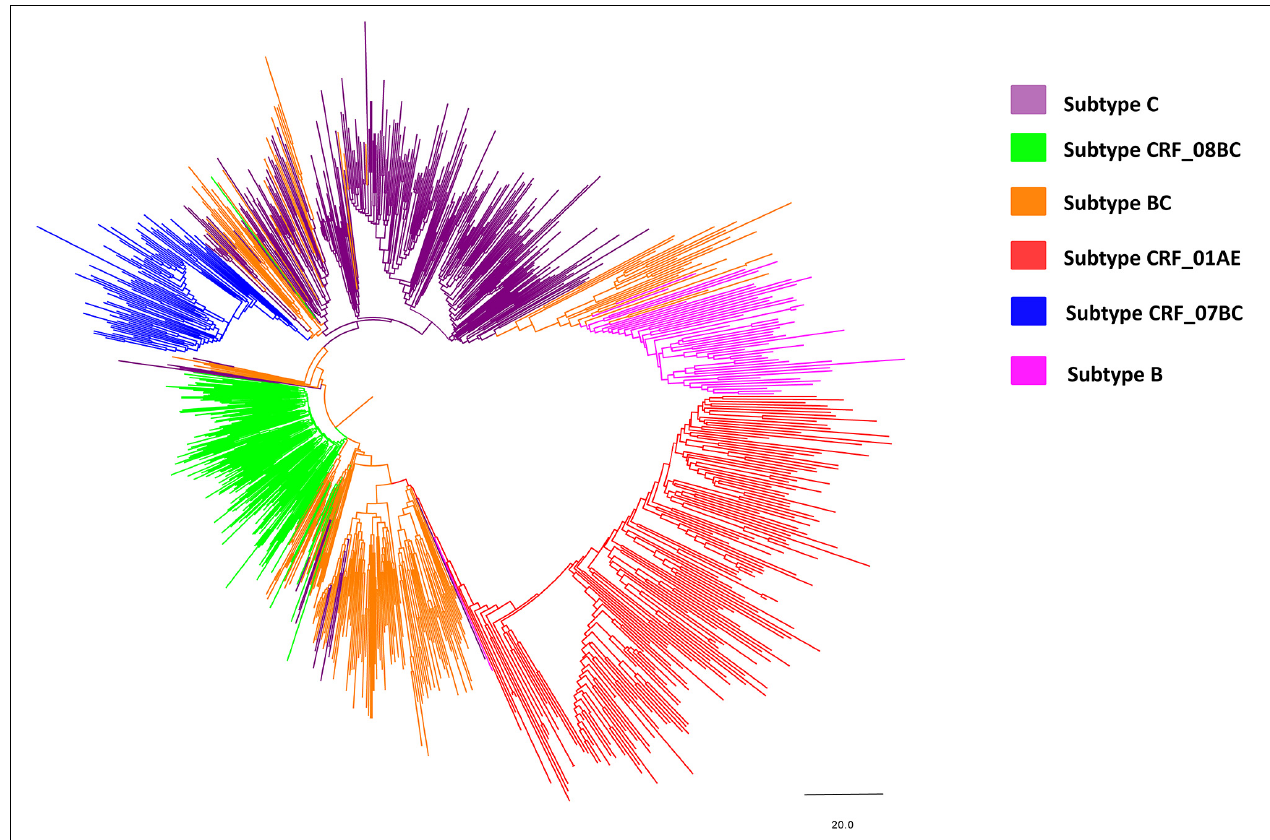
FIGURE 2 | Neighbor-joining phylogenetic tree of the whole pol gene. The neighbor-joining phylogenetic tree was constructed using MEGA 7.0 with 1,000 bootstrap replicates. The nucleotide substitution model was the Kimura 2-parameter model. The line with different colors indicates different subtypes/recombinant forms of HIV-1. Purple, green, orange, red, blue and magenta lines denote subtype C, CRF_08BC, BC, CRF_01AE, CRF_07BC, and subtype B,